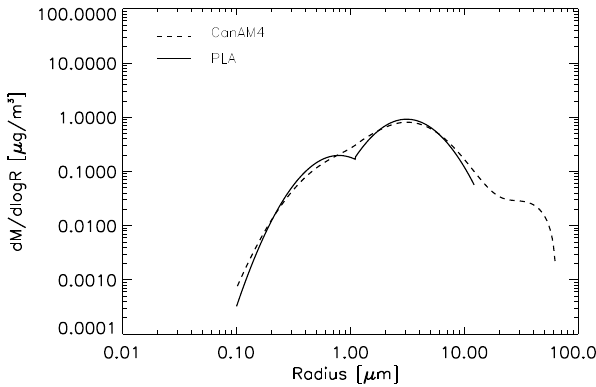
Fig. 2. Annual global mean size distribution of emitted dust mass. Fig.2. Annualglobalmeansizedistributionofemitteddustmass. Thedashedlineistheemitteddustin192prescribedbinsinCanAM4. ThesolidlineisaPLAdistributionfittingtotheparameterizeddustemission,thetwoPLAsizesectionsareforsubmicron([0.1,1] µ m)and The dashed line is the emitted dust in 192 prescribed bins in supermicron([1,10] µ m)respectively. CanAM4. The solid line is a PLA distribution fitting to the parame- terized dust emission, the two PLA size sections are for submicron ([0.1,1]µm) and supermicron ([1,10]µm),